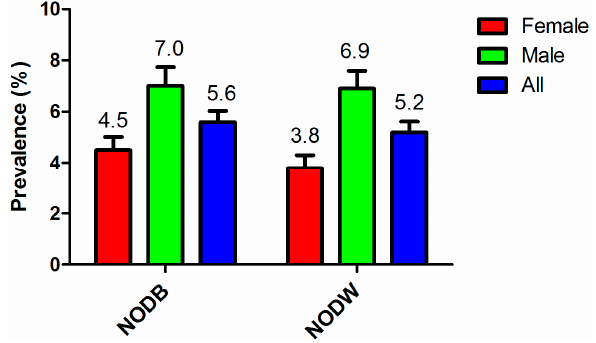
Figure 1. The prevalence of non-obese diabetes based on BMI (NODB) and waist circumference (WC) (NODW) among males and females. A significantly higher prevalence was observed in males than in females, both for NODB and NODW ( p < 0.05 with chi-square test).